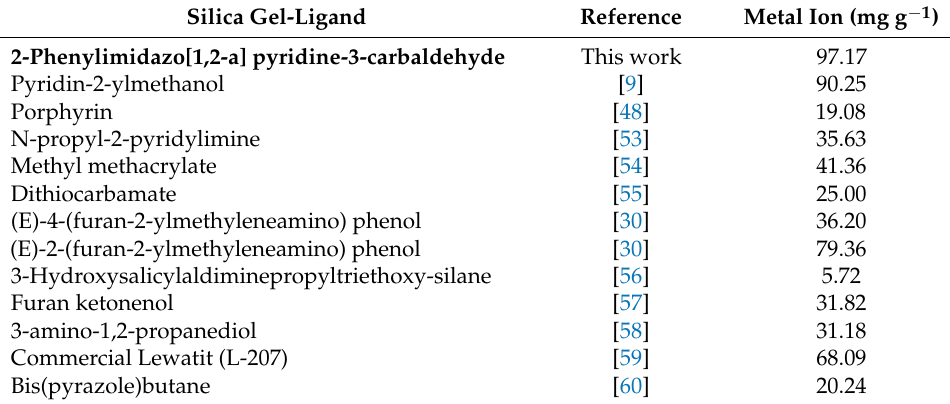
Table 7. Comparison of the maximum adsorption capacities of Cu(II) by different adsorbents reported in the